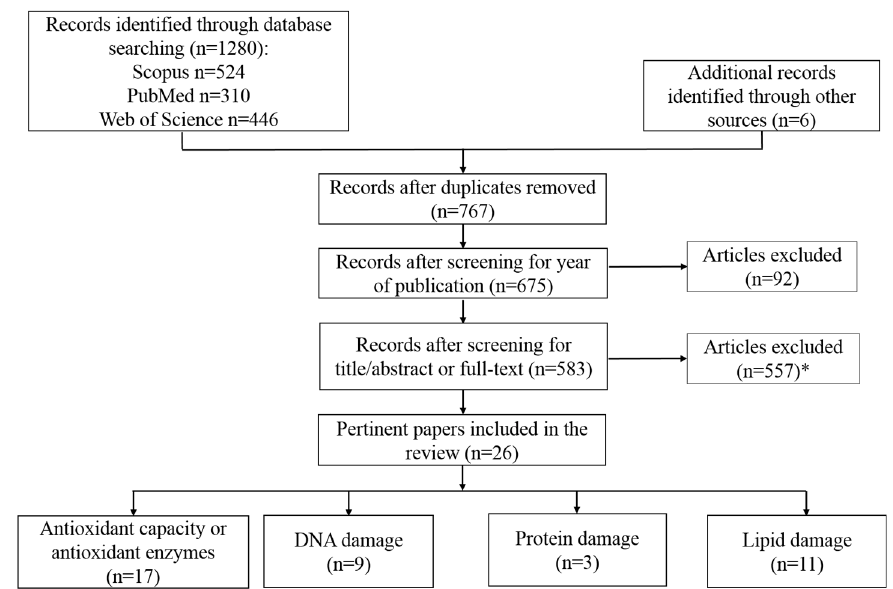
Figure 2. Flow diagram of article selection. * Studies were excluded for the following reasons: (1) not in English; (2) did not concern intervention studies; (3) not including in vivo markers of oxidative stress.